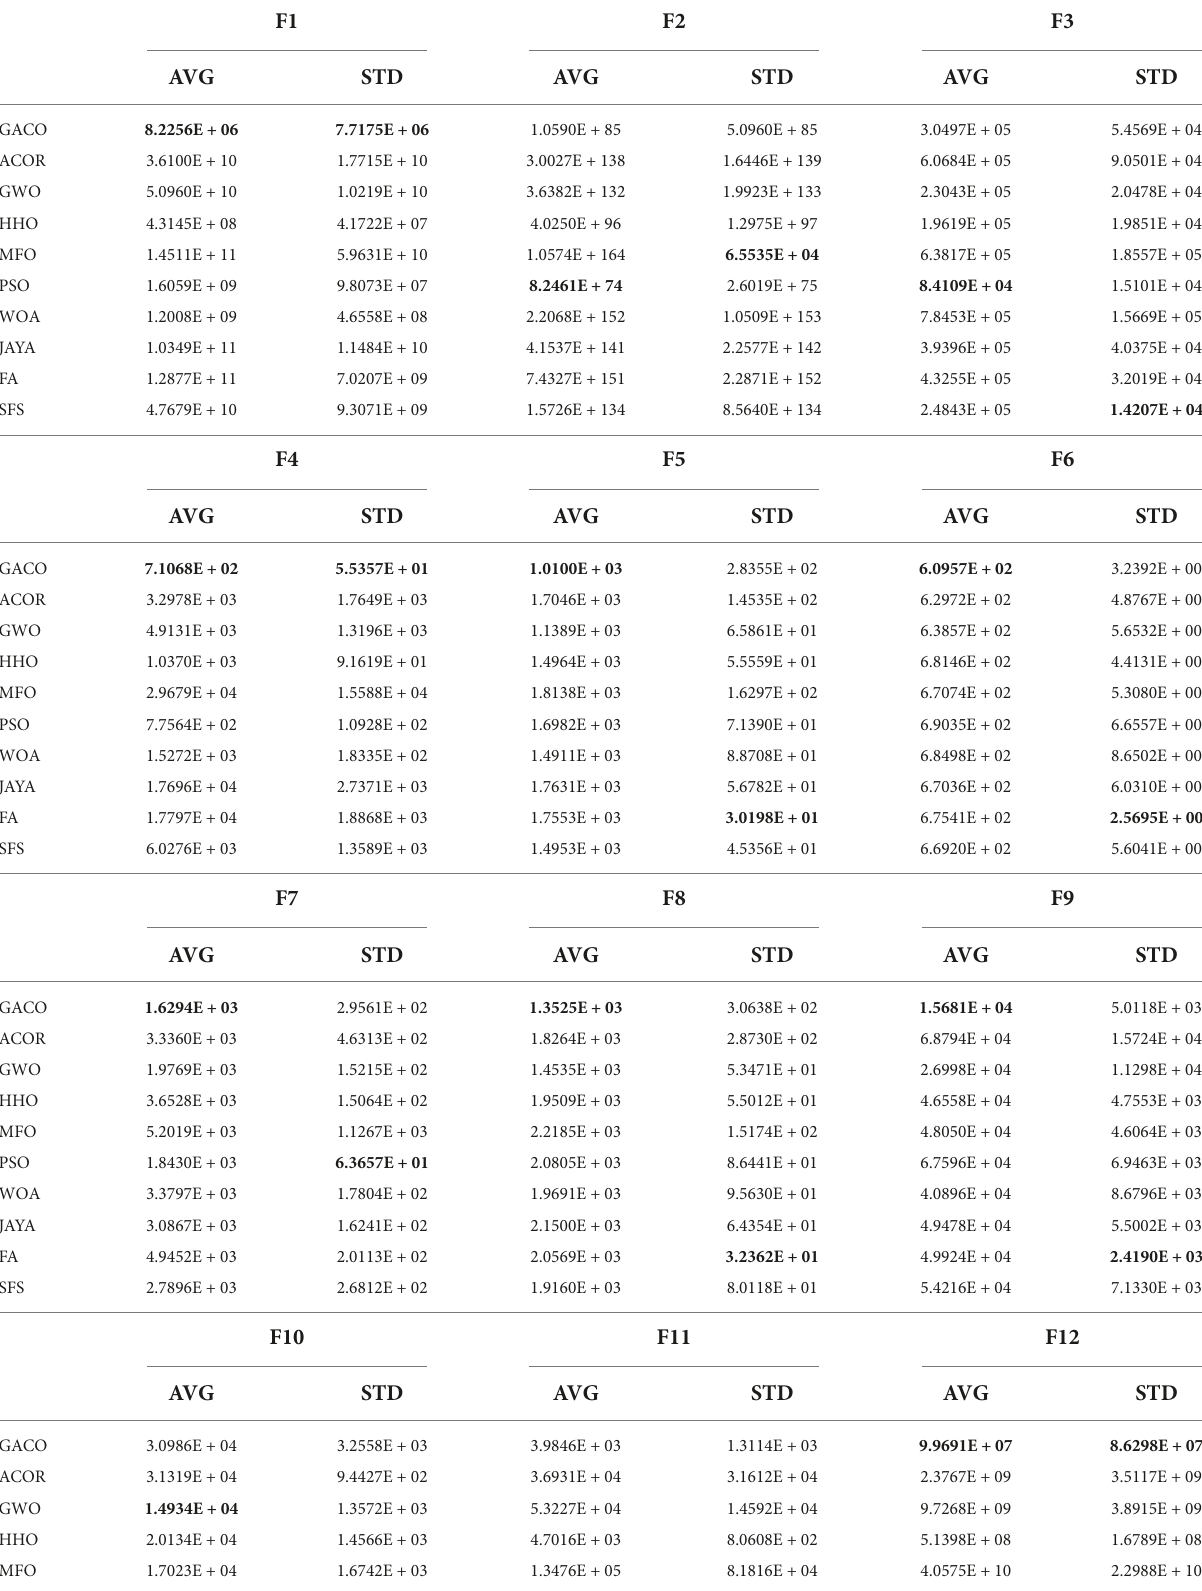
TABLE 6 The average values and the standard deviations obtained by GACO and basic